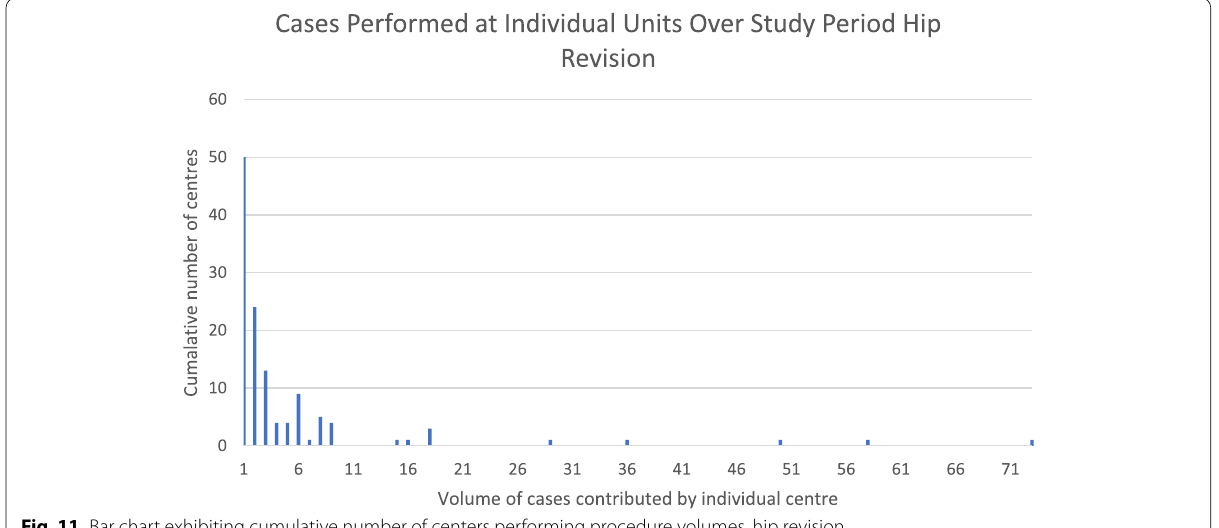
Fig. 11 Bar chart exhibiting cumulative number of centers performing procedure volumes, hip